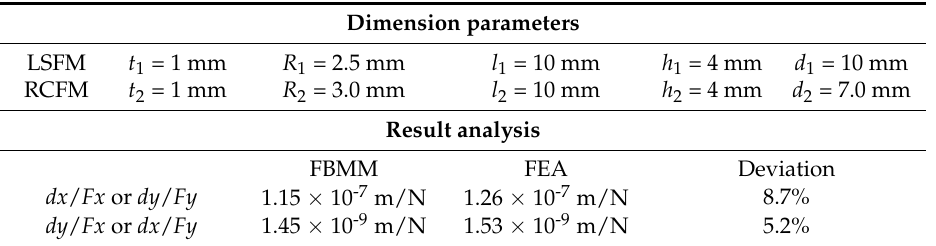
Table 1. The dimension parameters and result comparisons for the 2-DOF